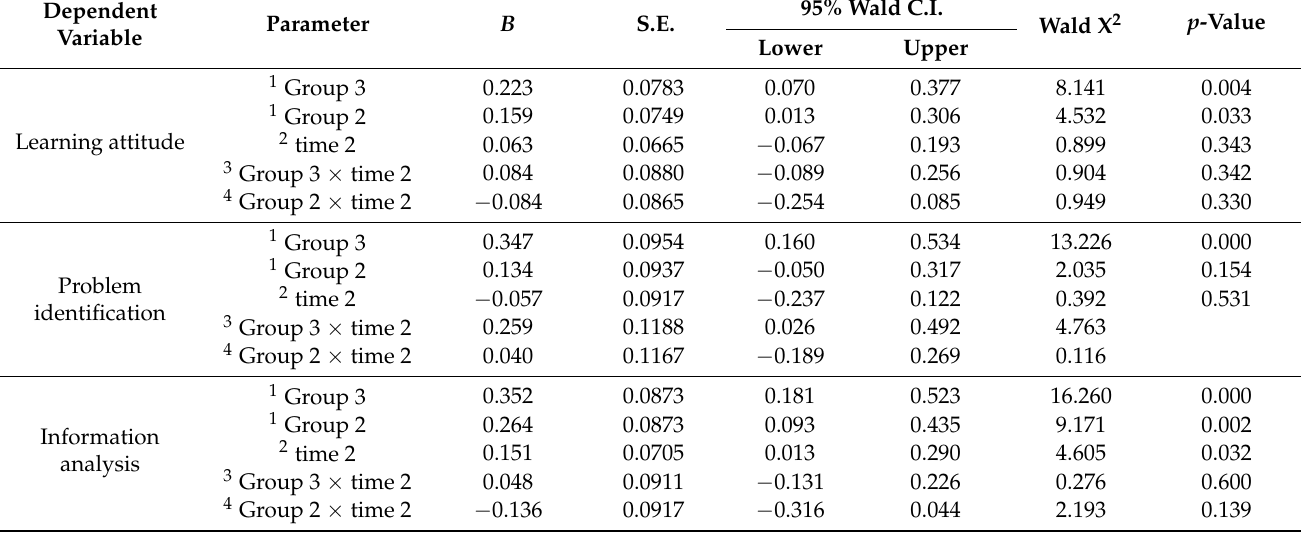
Table 4. Predictions of changes in the students’ self-evaluations of their core competencies (GEE